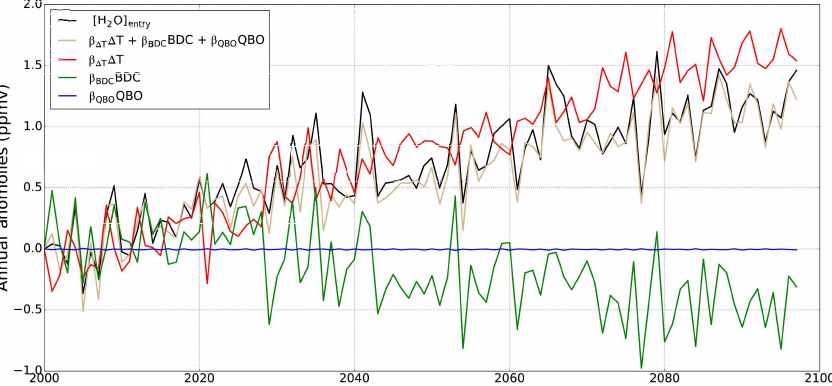
Figure 2. Time series of annual-averaged anomalies of [ H 2 O ] entry from the MRI (black), and its reconstruction using a multivariate linear regression (brown). The red, green, and blue lines are the (cid:49)T , BDC, and QBO terms from the regression,